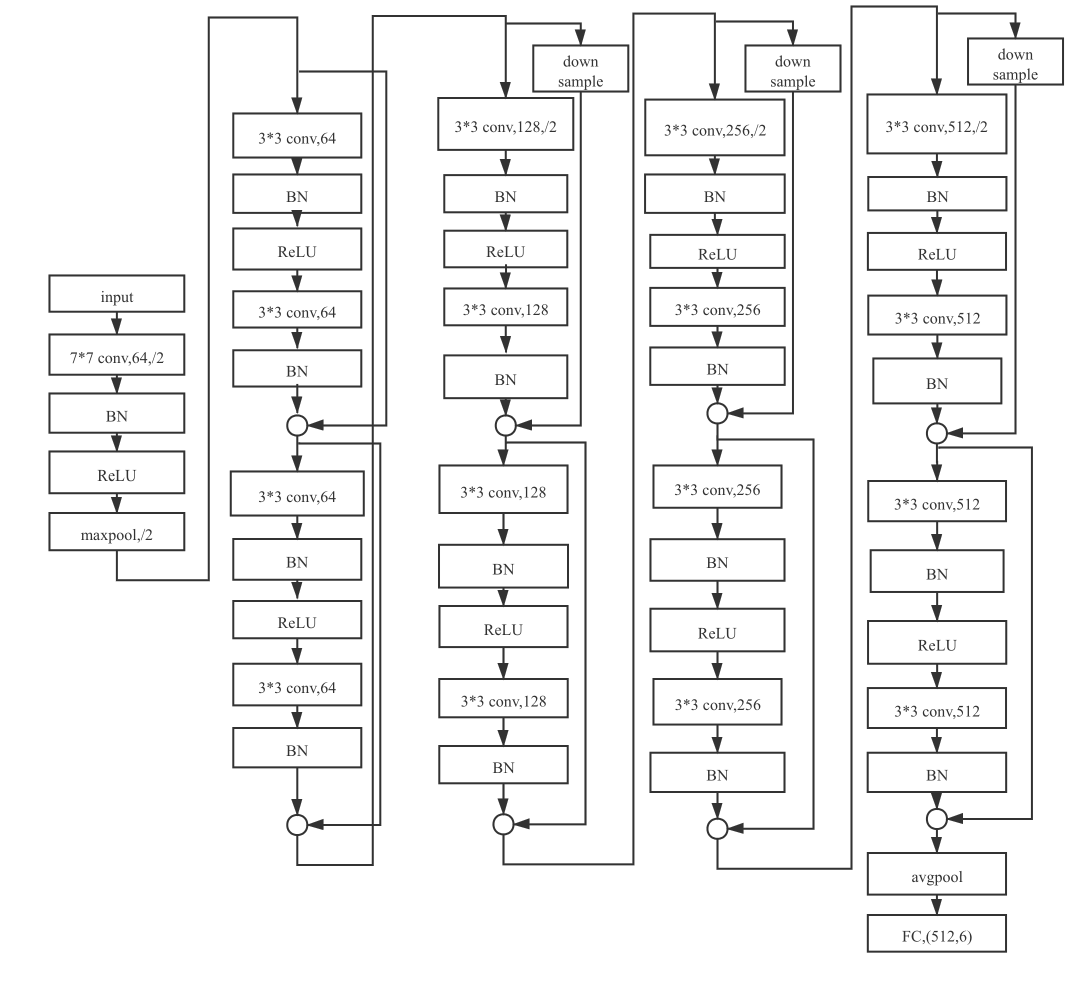
Figure 9. Schematic diagram of